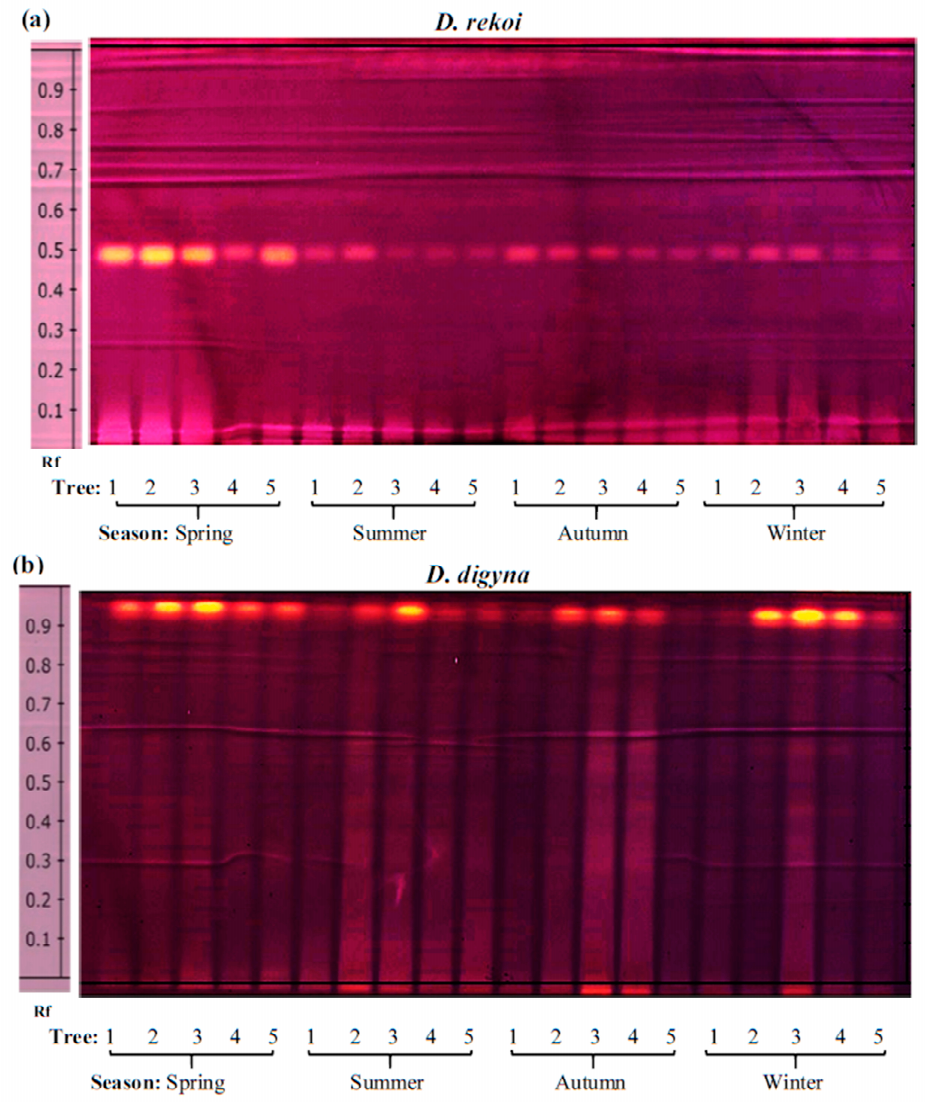
Figure 6. Antioxidant activity in D. rekoi and D. digyna leaf extracts. Bands showing antioxidant activity using the DPPH reagent were detected in polar leaf extracts previously separated on HP-TLC plates. The aqueous methanol extracts were obtained from leaves of five ( a ) D. rekoi and ( b ) D. digyna trees (Trees: 1–5) that were systematically sampled in the spring, summer, autumn, and winter of 2014, respectively. Band Rf values are represented on the left-side end of the figures.